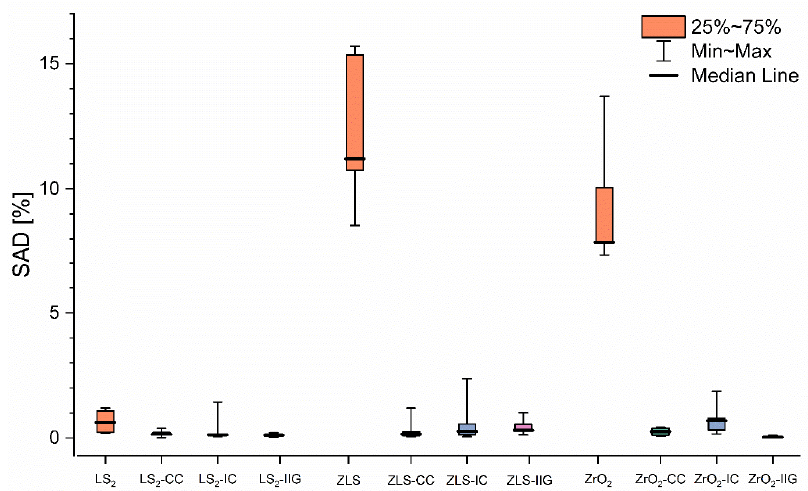
Figure 3. The average roughness (Ra) data for 20 μ m × 20 μ m area of the tested ceramic surfaces before and after glazing.